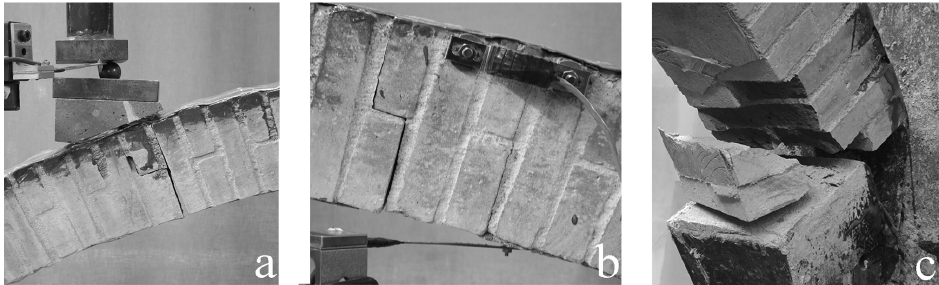
Figure 10. CFRP ‐ strengthened arch: ( a ) hinge 1; ( b ) opening of hinge 2; ( c ) joint sliding at the right abutment.